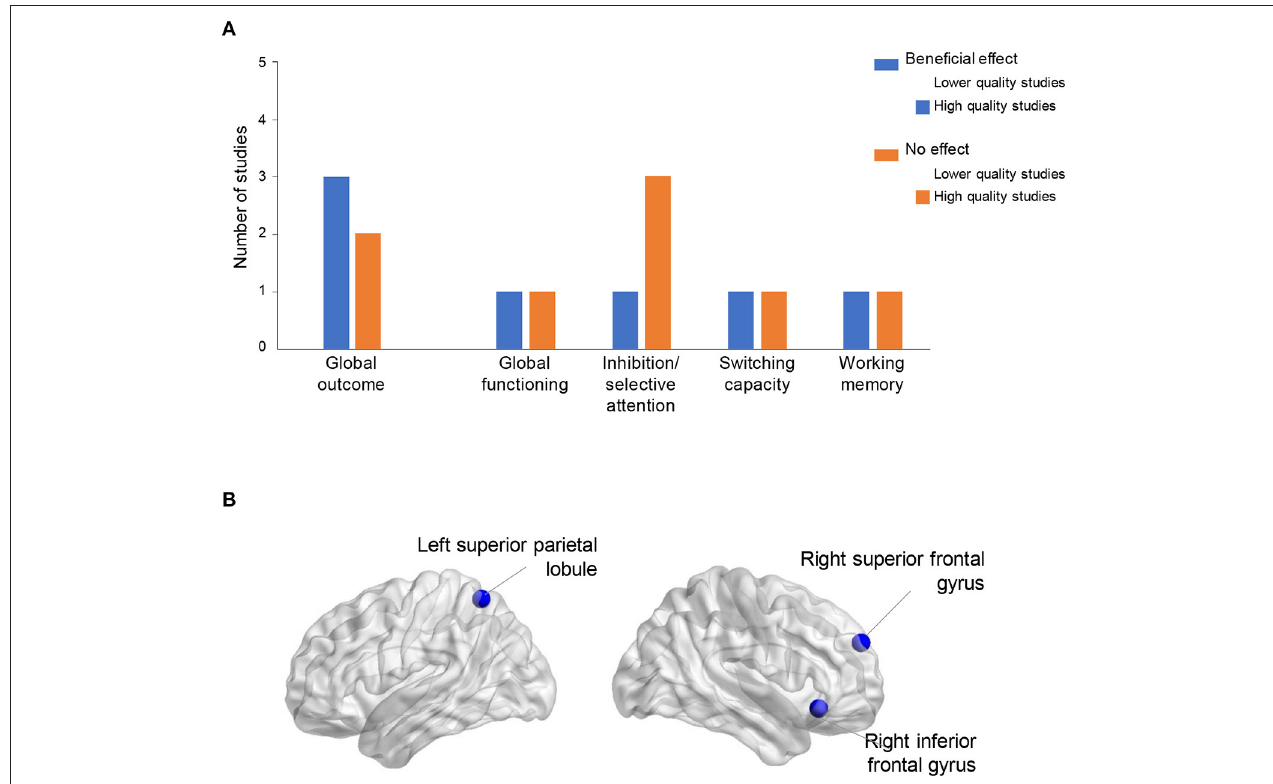
FIGURE 2 | Effects of SLA on cognition and functional connectivity in older adults. (A) Combined results from the 9 reviewed studies on cognition. (B) Influence of second language learning on functional connectivity ( Bubbico et al.,